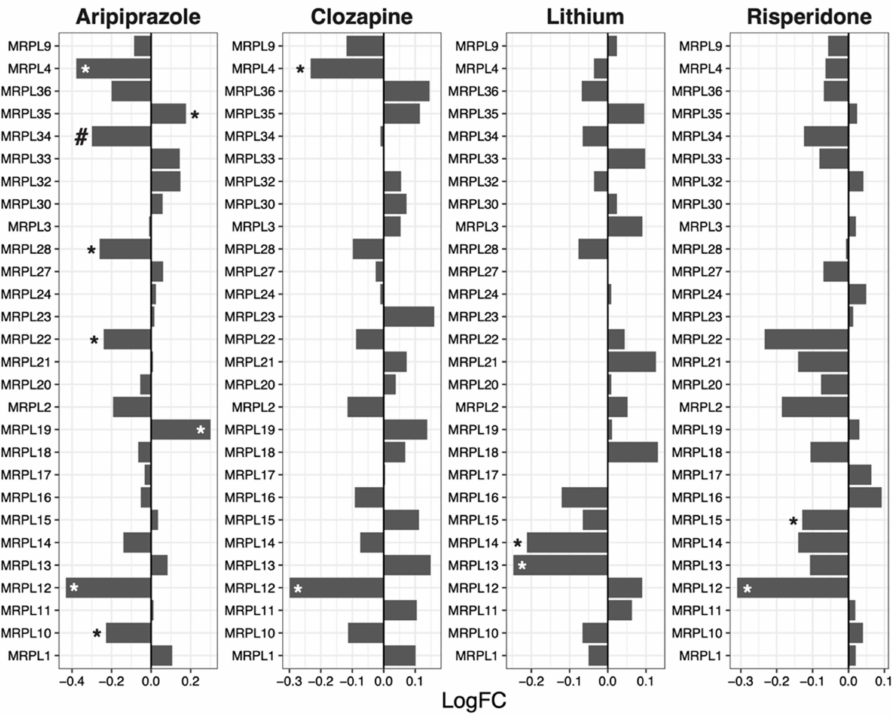
Figure 4. Effects of psychotropic drugs on the expression of genes encoding components of the